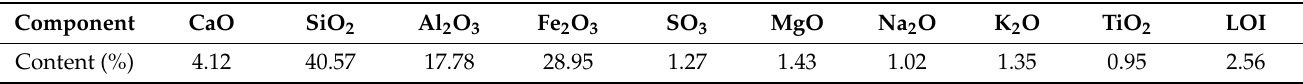
Table 2. FPSA chemical